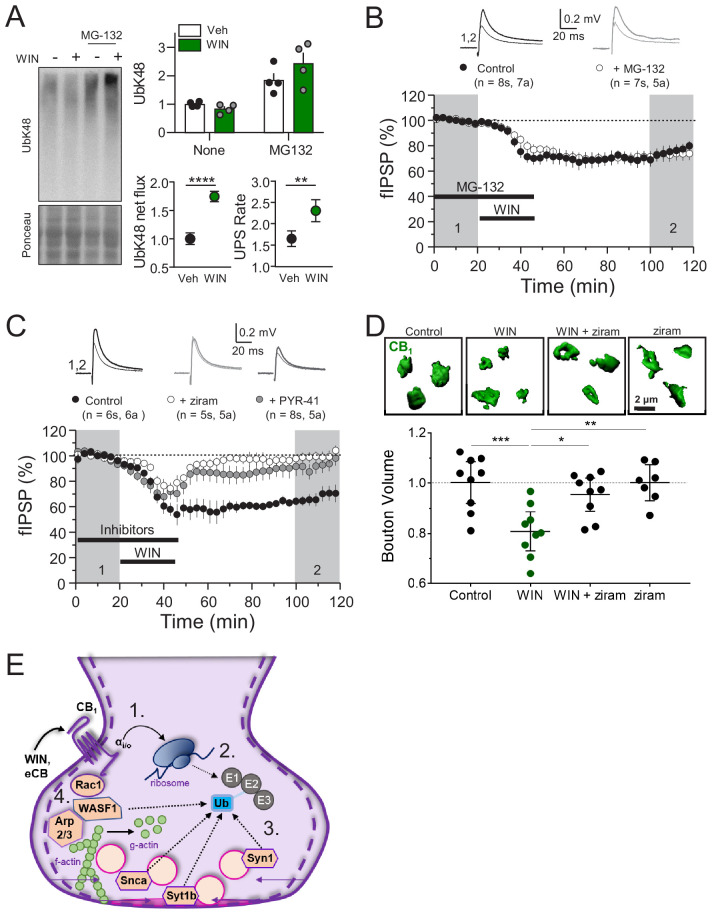
CB1-iLTD requires ubiquitination, but not degradation by the proteasome.(A) Left, representative Western blot images of K48 polyubiquitin in hippocampal slices treated with Veh v. WIN or Veh v. WIN and MG-132. Right, top: Levels of K48 polyubiquitin following CB1 activation with WIN (5 µM, 25 min). Bottom left: UPS net flux [difference between basal (none) and proteasome blockade (MG-132) condition] is significantly increased upon CB1 activation. Control: 1.0 ± 0.04 vs. WIN: 1.74 ± 0.04, unpaired t-test, ****=p < 0.0001, n = 5 animals. Bottom right: UPS rate [ratio between MG-132 and basal condition] of K48 polyubiquitinated protein degradation is significantly increased after WIN. Control: 1.65 ± 0.08 vs. WIN: 2.31 ± 0.12, unpaired t-test, **=p < 0.01, n = 5 animals. (B) Blockade of the proteasome by bath application of MG-132 (5 µM) had no effect on iLTD. Control: 77.6 ± 4% vs. MG-132: 73.3 ± 5%; p>0.05, unpaired t-test. For all electrophysiology figures, averaged summary data expressed as normalized change from baseline ± S.E.M. and n = number of slices (s), number of animals (a). (C) Inhibiting ubiquitination with ziram (25 µM) or PYR-41 (50 µM) fully blocked iLTD. Control: 66 ± 5 vs. ziram: 99 ± 4 vs. PYR-41: 93 ± 6; F[2,19]=10.22; p<0.05, one-way ANOVA. (D) Blockade of E1 ubiquitin ligase function with ziram (25 µM, 25 min) rescued the volumetric decrease associated with CB1 activation by WIN (5 µM, 25 min). Top, representative inhibitory boutons immunolabeled with CB1 and reconstructed in 3D. Bottom, quantification of normalized mean CB1 bouton volume per slice. Control: 1.0 ± 0.04 vs. WIN: 0.81 ± 0.03 vs. WIN + ziram: 0.95 ± 0.03 vs. ziram: 1.0 ± 0.03 (mean ± S.E.M.); F[3,30]=8.11, p=0.0004, one-way ANOVA with post-hoc Tukey test for multiple comparisons. Control vs. WIN: CI[0.07,0.32], p=0.0008; WIN vs. WIN + ziram: CI[−0.27,–0.025], p=0.014; WIN vs. ziram: CI[−0.32,–0.063], p=0.0018. n = number of slices (three images/slice, one slices/rat, nine rats/condition for Control, WIN, WIN + ziram, seven rats/condition for ziram). For all structural plasticity figures, data are presented as points representing mean bouton volume per slice with a horizontal black line representing the mean per condition and the vertical line indicating 95% confidence interval (CI). 95% CIs are given as CI[lower CI, upper CI]. p-Values are exact. Refer to Figure 5—figure supplement 1E for distribution of individual bouton values. (E) Schematic summary of proposed mechanism of CB1–iLTD 1. CB1 activation rapidly engages presynaptic protein synthesis (Younts et al., 2016). 2. CB1–iLTD increases components of the ubiquitin/proteasome system and leads to enhanced proteasomal activity (Figure 4A,B and (A)) 3. Ubiquitination is required for concomitant decrease in the volume of the bouton (D) and reduction in neurotransmitter release (C). 4. CB1–iLTD involves signaling via Rac1 and Arp2/3 and actin dynamics.